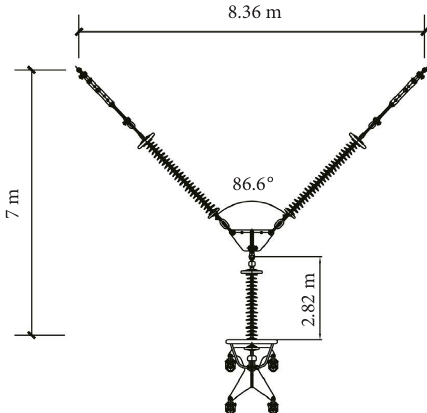
Figure 17: Te optimization of the included angle of the Y -type insulator string. Table 9: Optimization results of the insulator